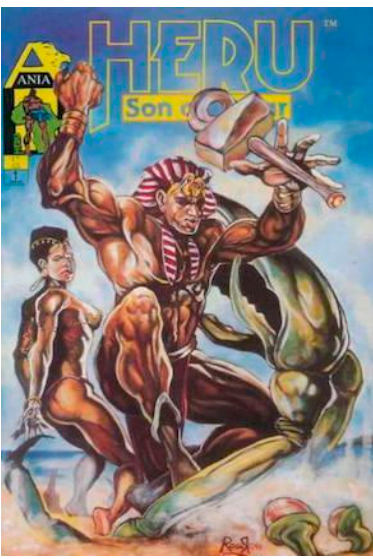
Figure 12. Sacred legends in Heru Son of Ausar . Afrocentric Comics, 1993.